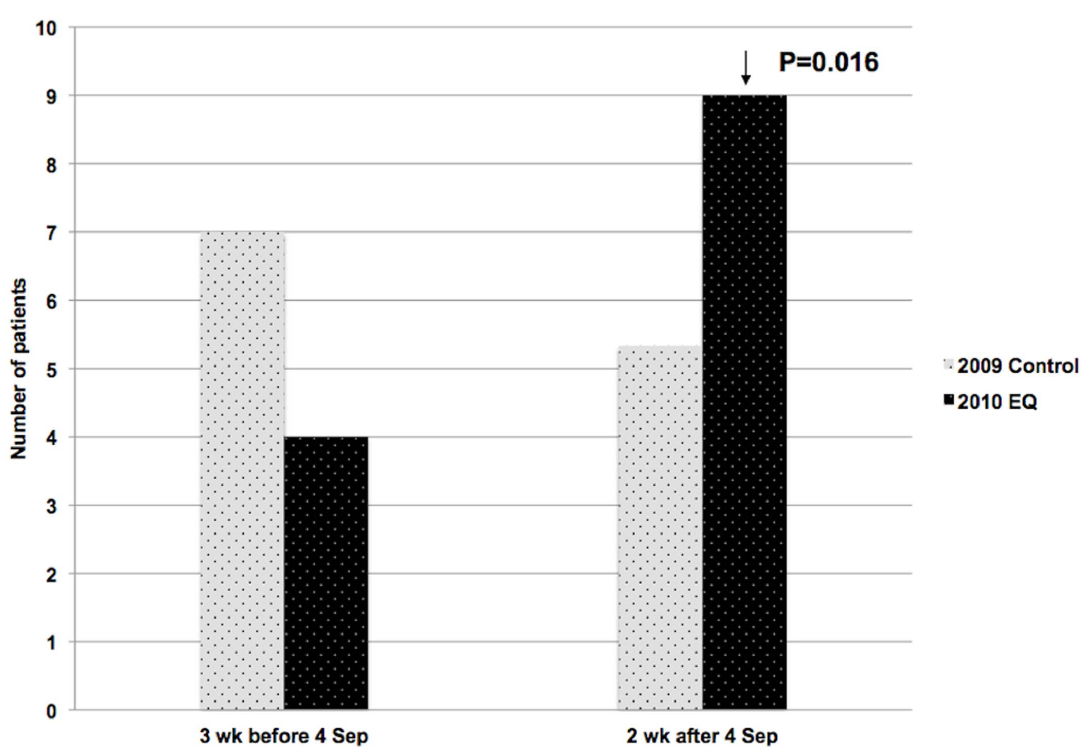
Figure 2. Mean STEMI admissions 3 weeks before and 2 weeks after the September 2010 earthquake.